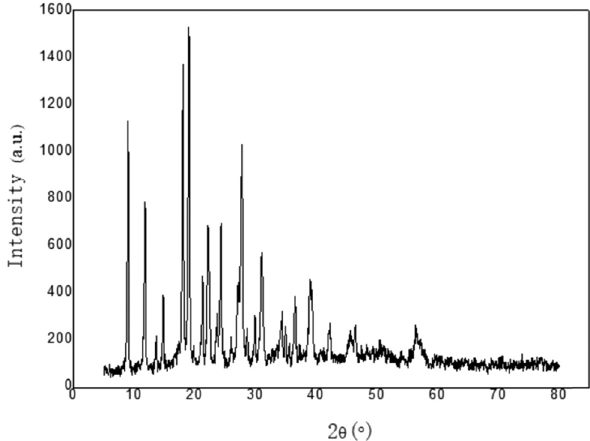
Figure 3: XRD of Zn -